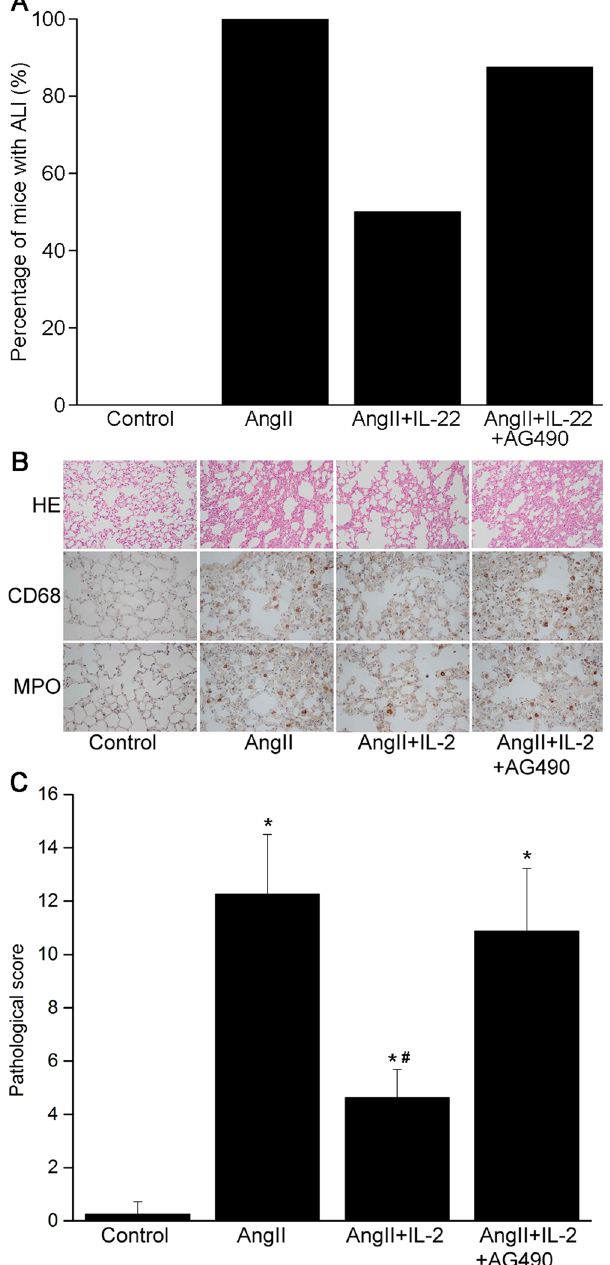
Figure 2. IL-22 attenuated the ALI induced by AngII. ( A ) The incidence of lung injury showed remarkable decrease after IL-22 treatment. ( B ) In the ALI model induced by AngII, obvious oedema was noticed, together with massive infiltration of neutrophils (MPO) and macrophages (CD68), which was significantly reversed after IL-22 treatment. ( C ) IL22 could significantly attenuate the lung injury as revealed by pathological changes, but such phenomenon was completely reserved after AG490. HE staining and immunohistochemistry images were observed under a magnification of 200 × and 400 × , respectively. * P < 0.05 versus control group. # P < 0.05 versus AngII group and AngII + IL-22 + AG490